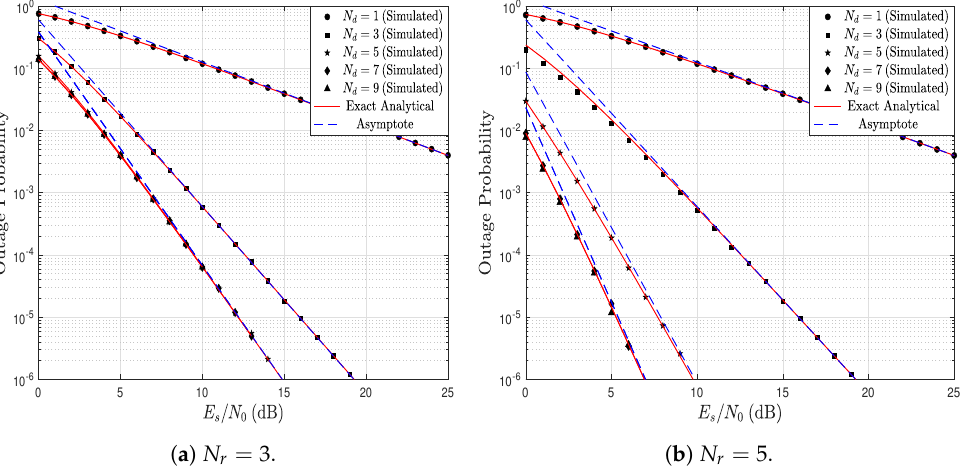
Figure 4. OP as a function of E s / N 0 , parameterized by N r and N d , considering k r = 2.5, k d = 2, and λ r = λ d =